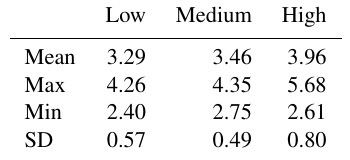
Table 2. Projections of zonal geostrophic wind in 2081–2100 at 55 ◦ N, 15 ◦ E: means, maxima, minima, and standard devia- tions (metres per second) among the 17-model ensemble under low-emission (RCP2.6), medium-emission (RCP4.5), and high- emission (RCP8.5) scenarios. The values are calculated so that the projected change from the historical period 1986–2005 is added to the observational average of 3.2ms − 1 over that period. Low Medium High Mean 3.29 3.46 3.96 Max 4.26 4.35 5.68 Min 2.40 2.75 2.61 SD 0.57 0.49